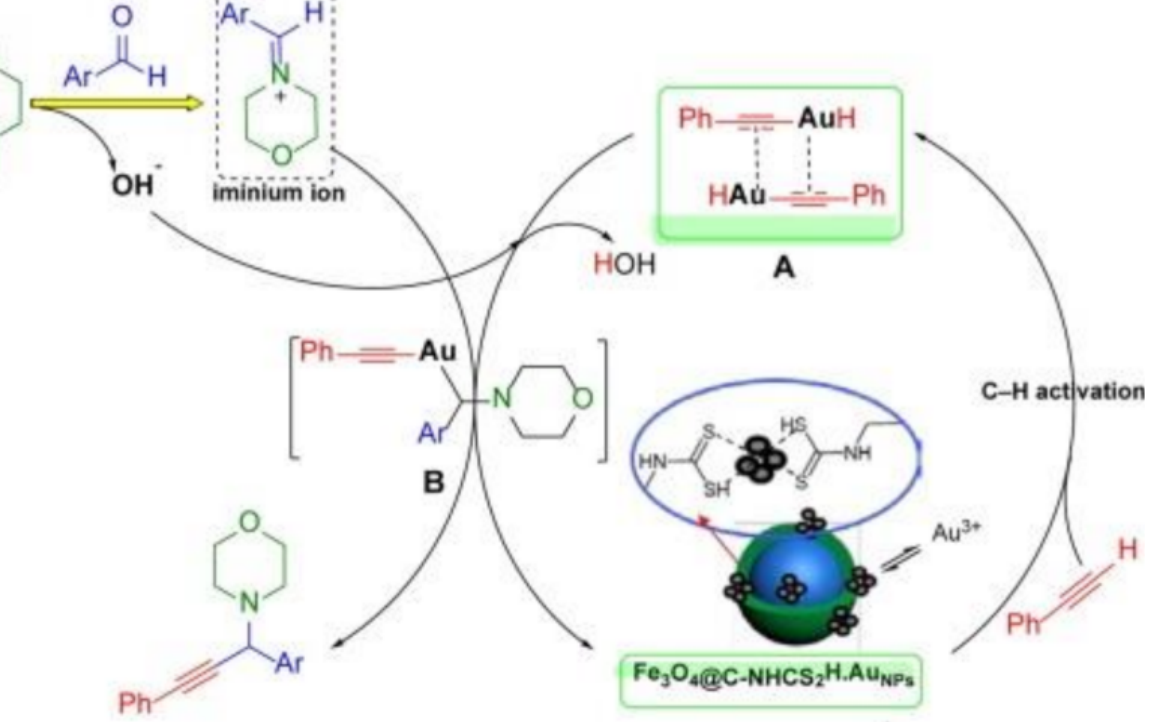
Figure 3. Mechanism for the dithiocarbamate-containing Au-catalyzed A 3 coupling. Reprinted from [44]. Copyright (2021), with permission from